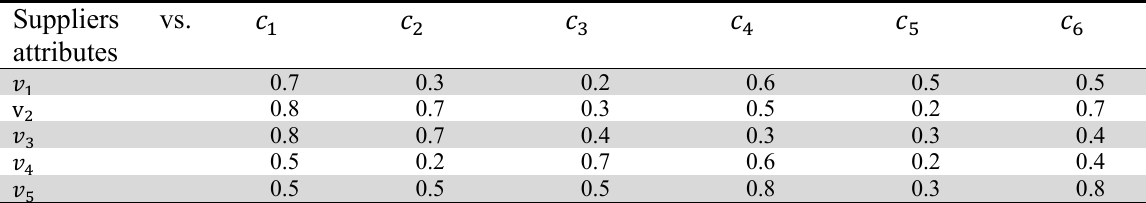
Performance scores of spare parts suppliers Suppliers